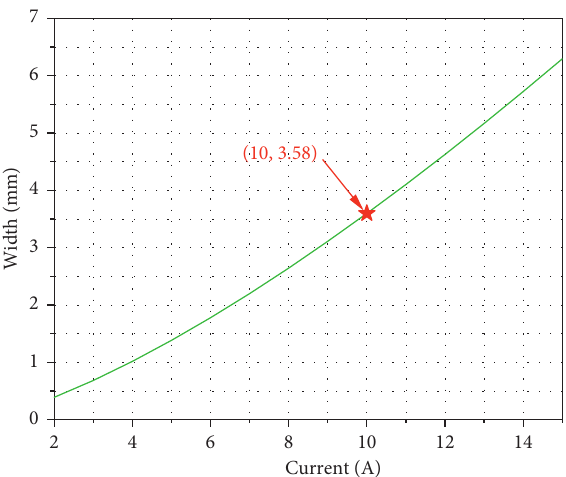
Figure 9: The relationship between the current and the width of the external microstrip line (dT � 10 ° C, M �